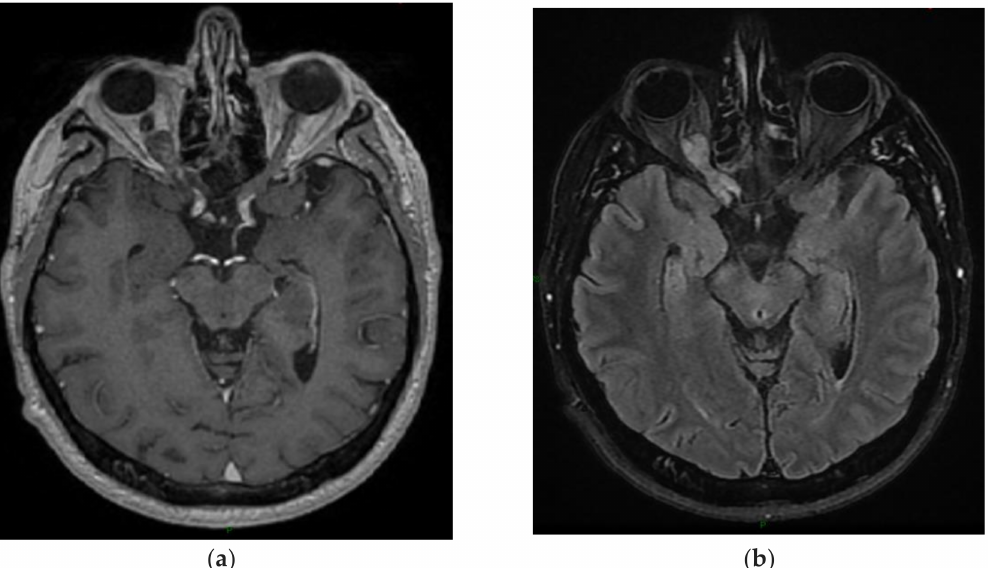
Figure 5. A 59-year-old male with pilocytic astrocytoma of the right optic nerve diagnosed at 49 years. After the diagnostic biopsy, the patient was treated with chemotherapy. ( a ) T1-weighted image after gadolinium infusion; ( b ) Flair-weighted